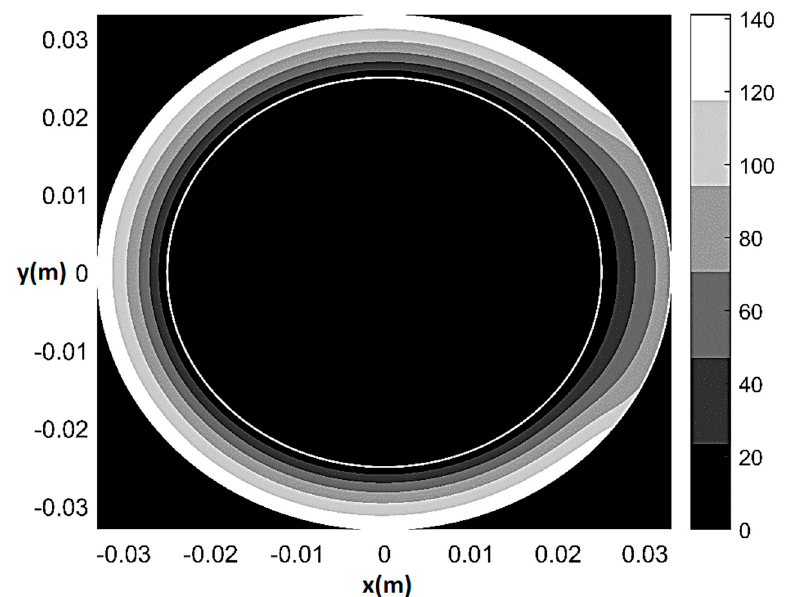
Figure 5. Pressure contour plot at rest for 80% CX stenosis ( q 0 = q 0 H = 2.7 × 10 − 9 m 2 /s, T / T H = 1, ξ = 0.55, Θ s = 72°, δ / δ H = 1). Pressure values in mmHg.